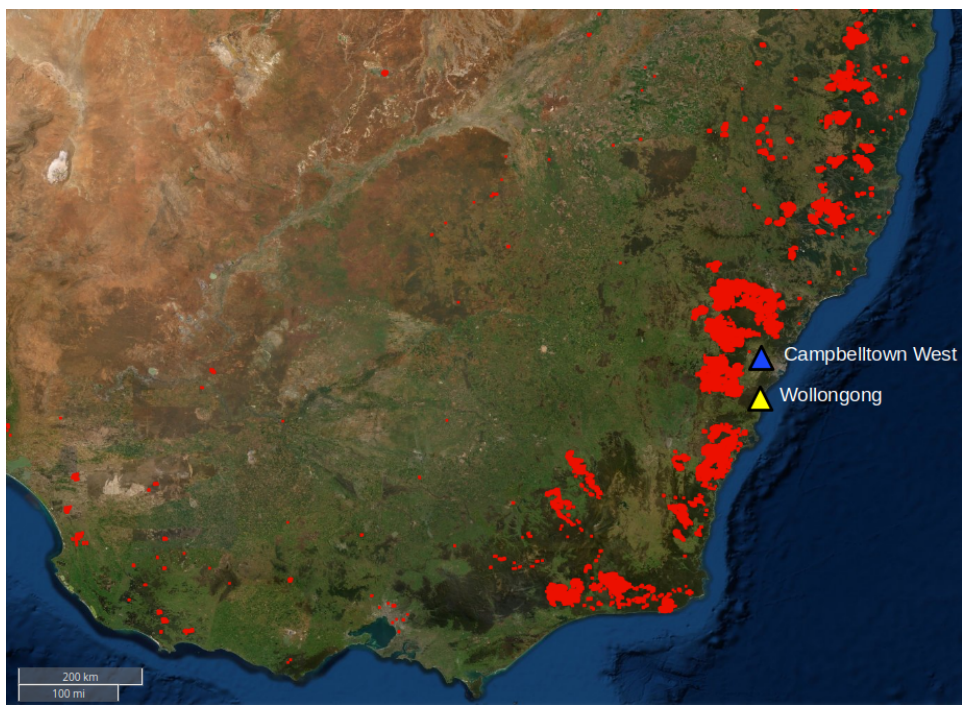
Figure 2. Study area: Zoomed in map of MODIS firecount over Southeast Australia [48] (28 ◦ S–40 ◦ S, 140 ◦ E–152 ◦ E) from 2 December 2019 to 1 January 2020 where the yellow triangle shows the surface in situ and column CO (TCCON & NDACC) measurement site at Wollongong (UOW: 34.406 ◦ S, 150.879 ◦ E) and the NSW DPIE air quality station at Wollongong (34.417060 ◦ S, 150.887330 ◦ E), which is located close to the UOW site. The blue triangle shows NSW DPIE air quality station at Campbelltown West (34.066670 ◦ S, 150.795540 ◦